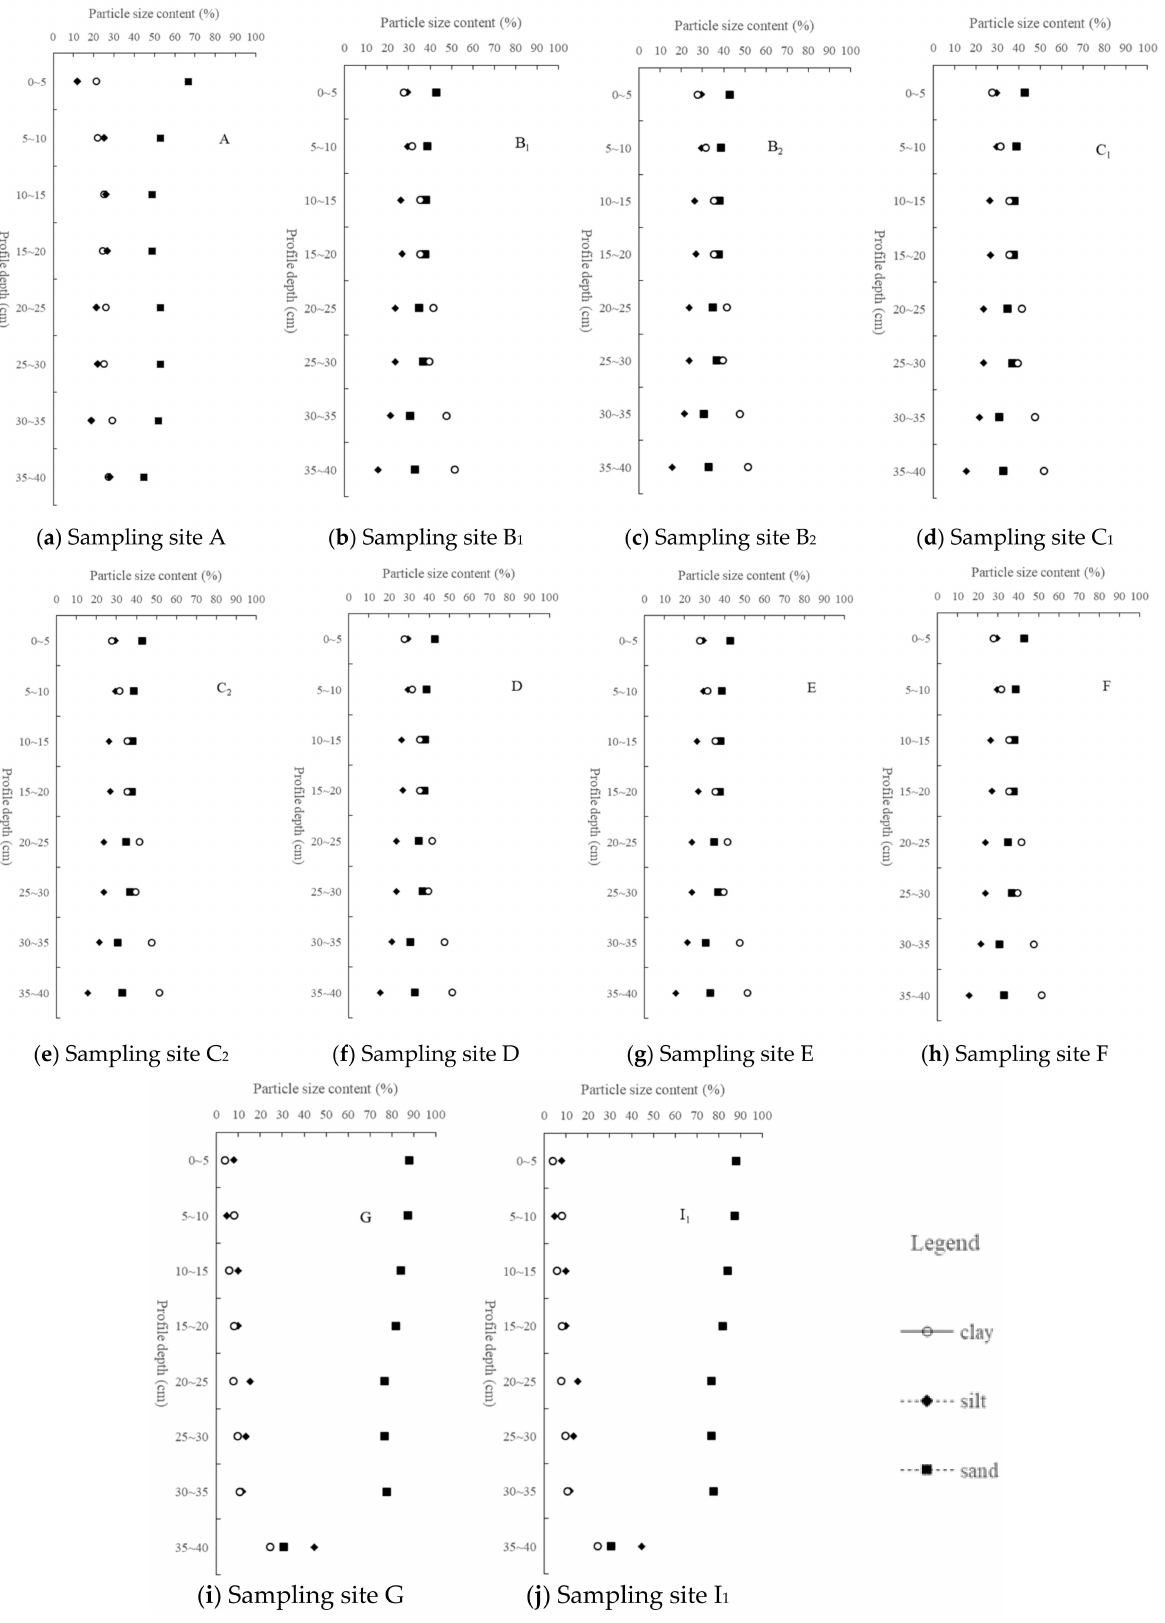
Figure 4. Particle size distribution of soil profiles in different soil samling